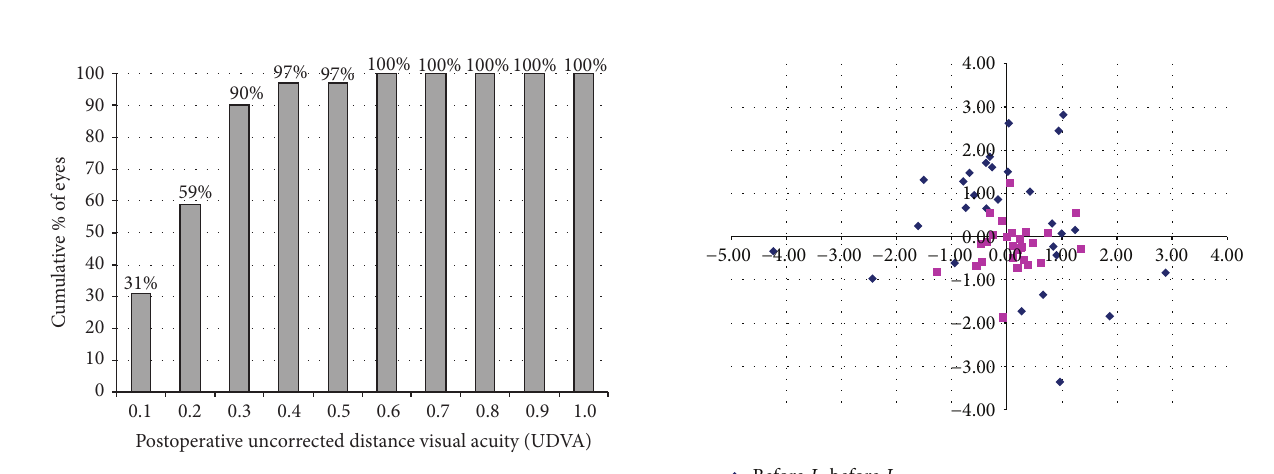
Figure 1: Distribution of the postoperative uncorrected distance visual acuity (UDVA) LogMAR.